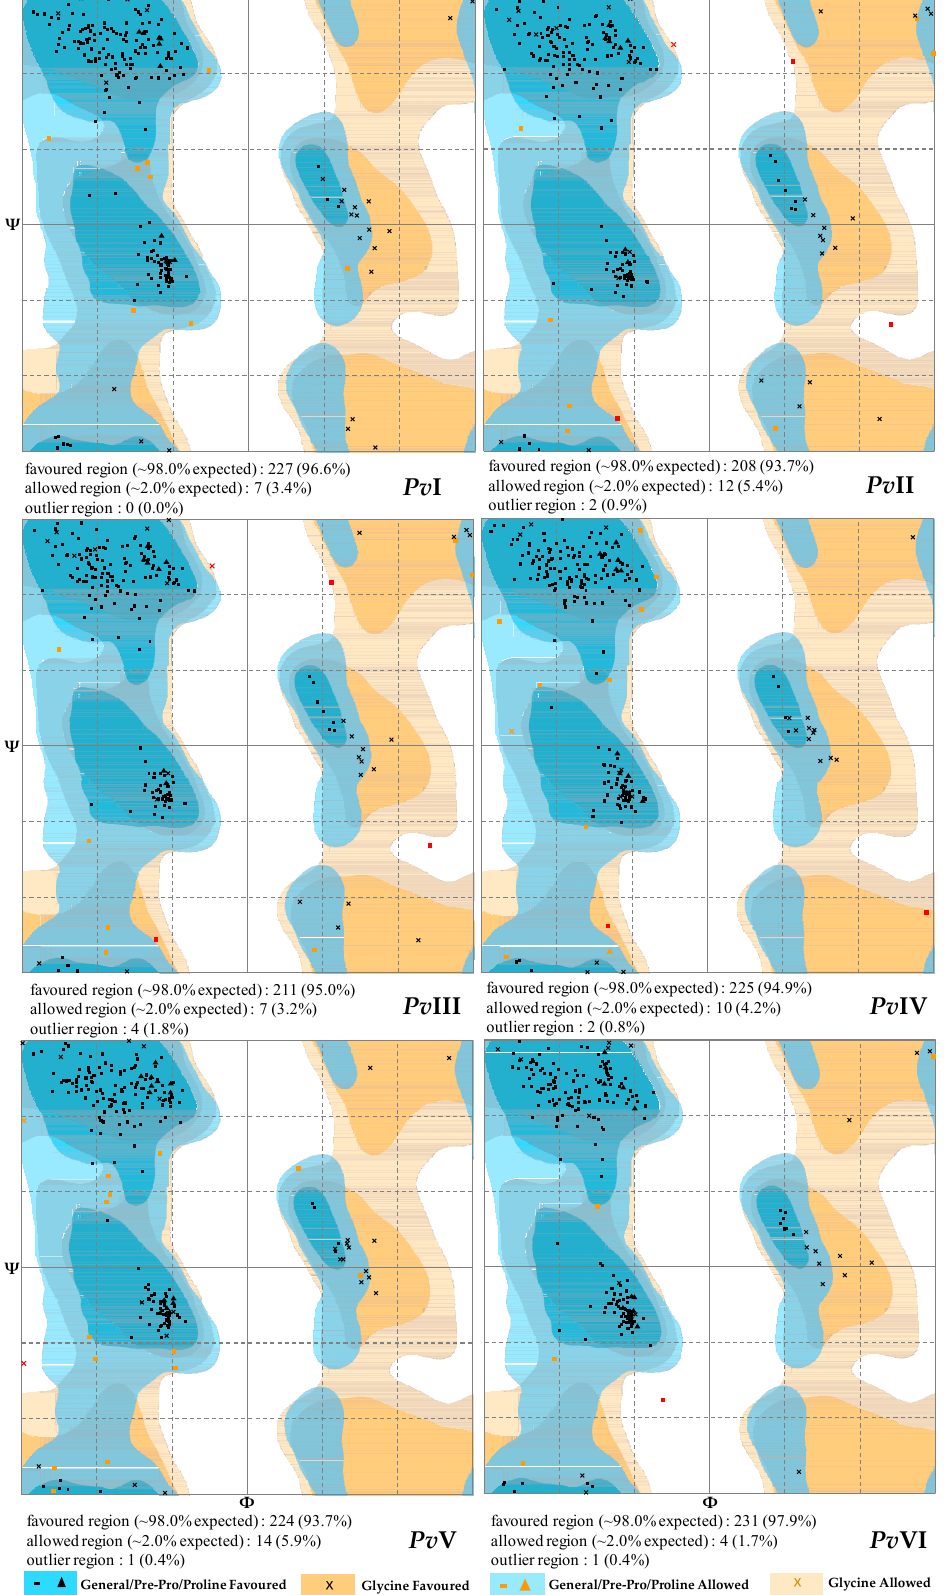
Figure 11. The PROCHECK Ramachandran plot of Pv I– Pv VI by RAMPAGE online software.